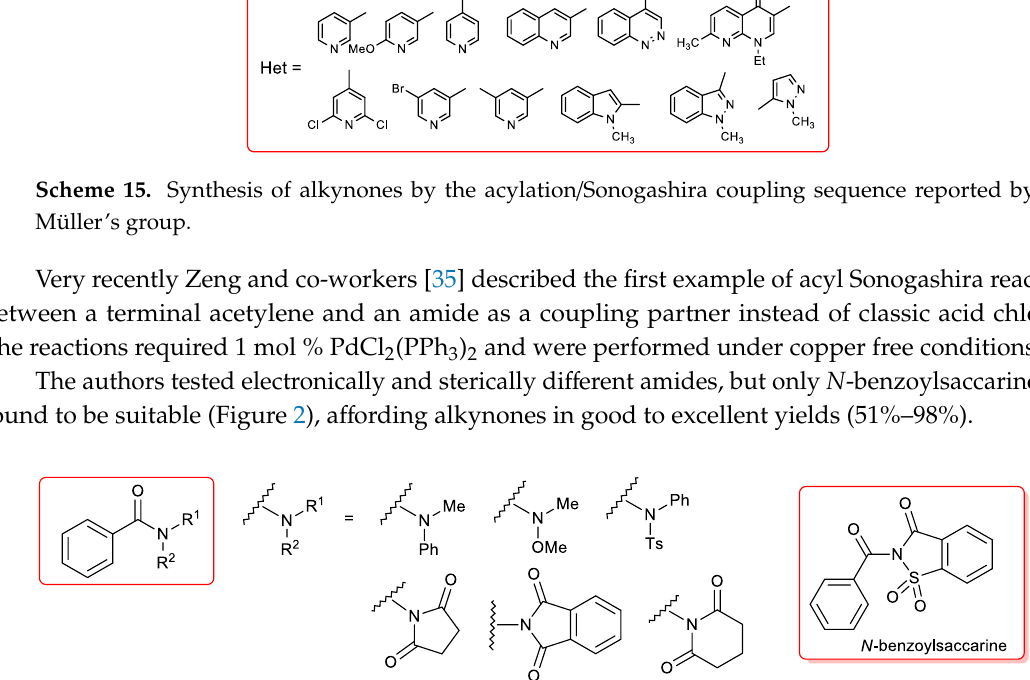
Figure 2. Pd(PPh 3 ) 2 Cl 2 -catalyzed Sonogashira coupling of amides.